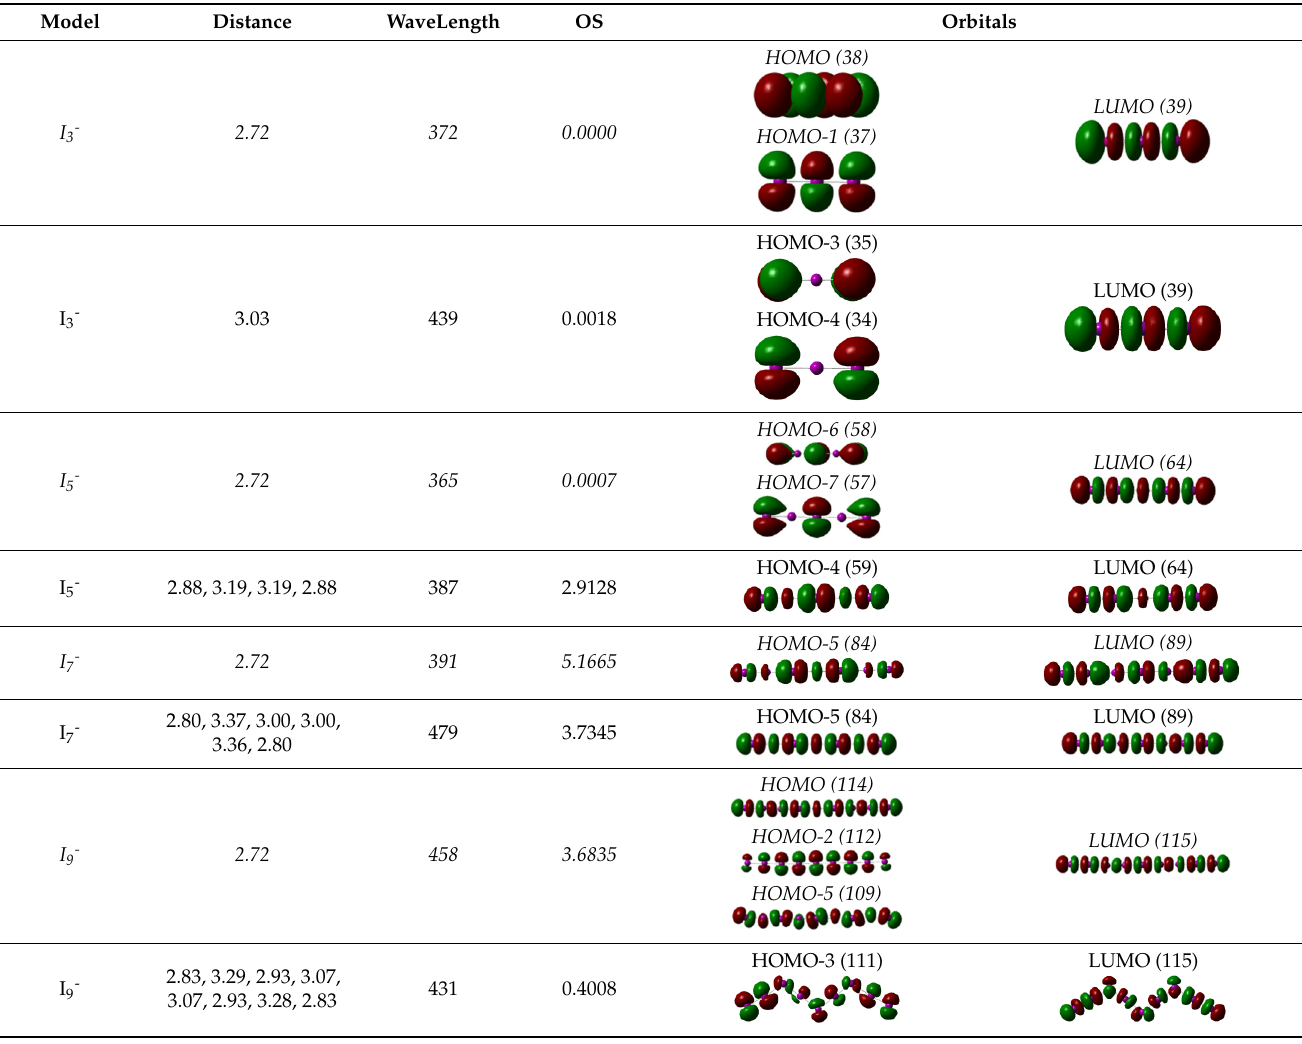
Table 2. I-I distances (Å), wavelengths for the major maximum in the visible region (nm), oscillator strengths (OS) and relevant molecular orbitals on linear I n- models from TD-DFT (B3LYP/def2- SV(P)) calculations. Data shown in italics are from single-point calculations on structures built with intramolecular I-I distances known experimentally for I 2 in solid state (2.72 Å). All other data are from optimized geometries.